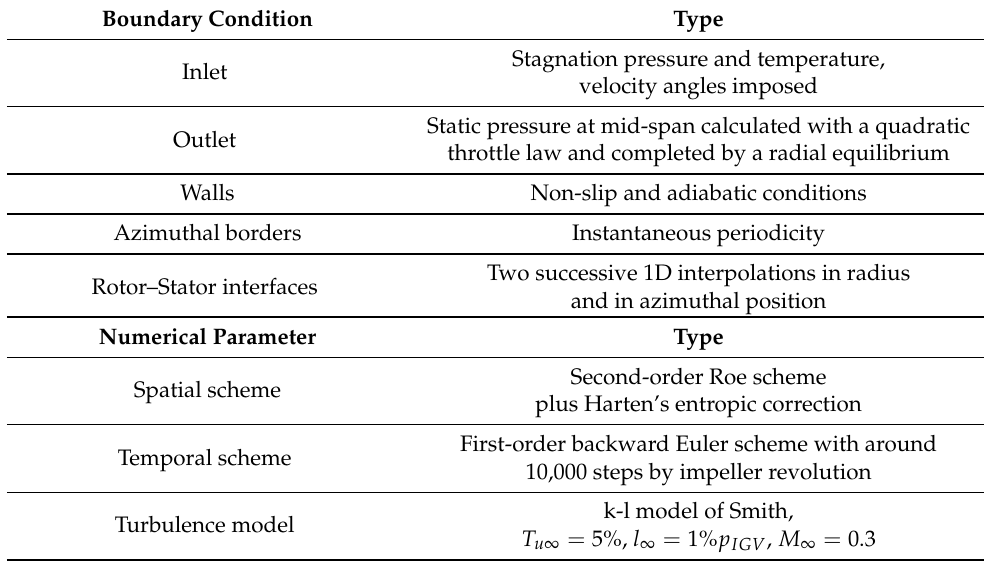
Table 1. Boundary conditions and numerical